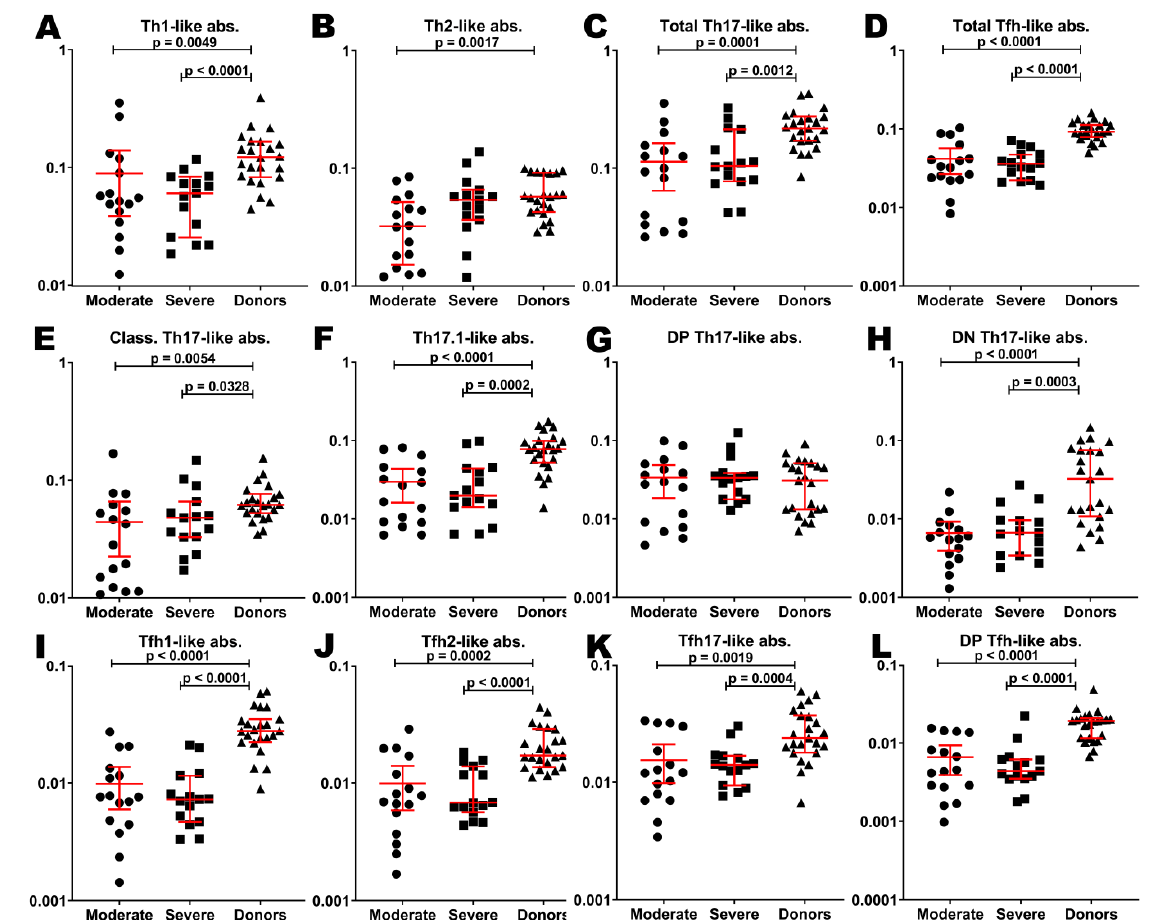
Figure 4. Basic Th cell subsets in patients with COVID-19 and in healthy donors. Absolute counts of Th1-like ( A ), Th2-like ( B ), total Th17-like ( C ), total Tfh-like ( D ), classical Th17-like ( E ), Th17.1-like ( F ), double-positive Th17-like ( G ), double-negative TH17-like ( H ), Tfh1-like ( I ), Tfh2-like ( J ), Tfh17-like ( K ), double-positive Tfh-like ( L ) cells. Long red lines demonstrate median value, short red lines demonstrate interquartile range.